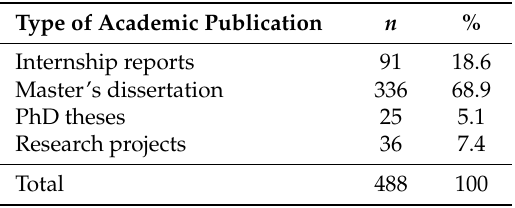
Table 4. Distribution of scientific production by type of academic publication ( n and %).